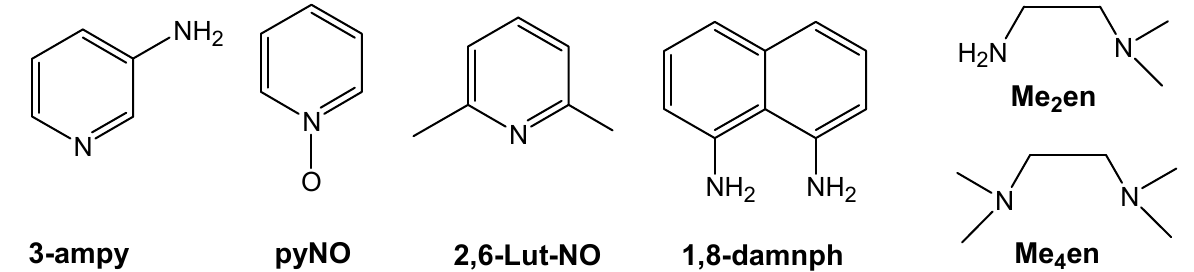
Scheme 2. The structural formulas and abbreviations of ligands used in this study.